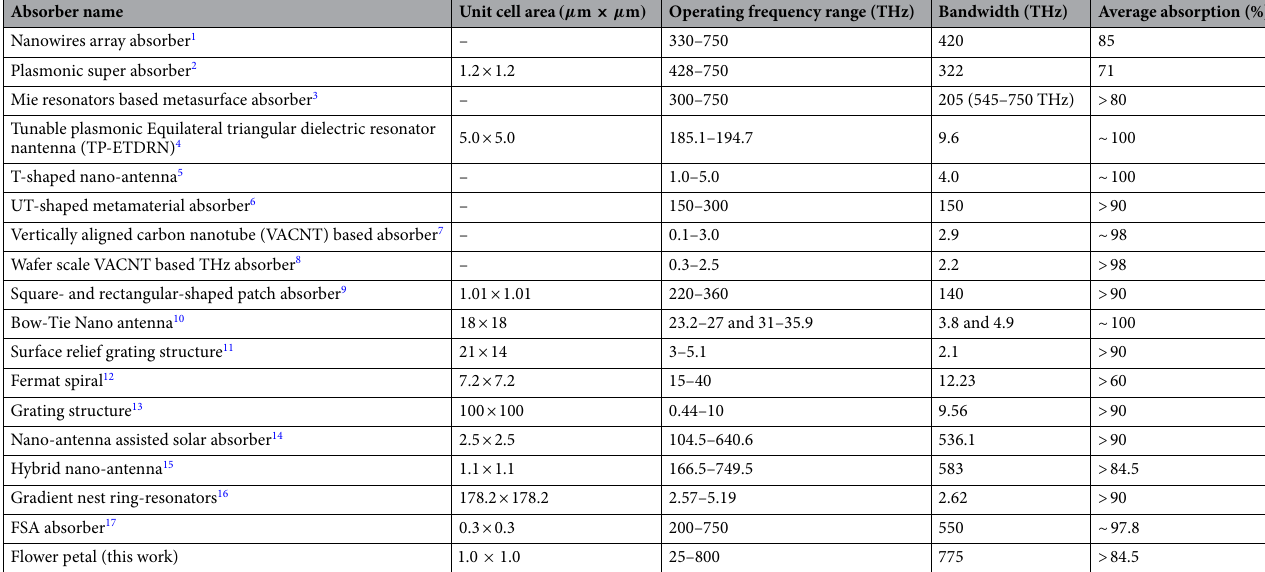
Table 4. Comparative study of different parameters of the proposed antenna with other absorbers.